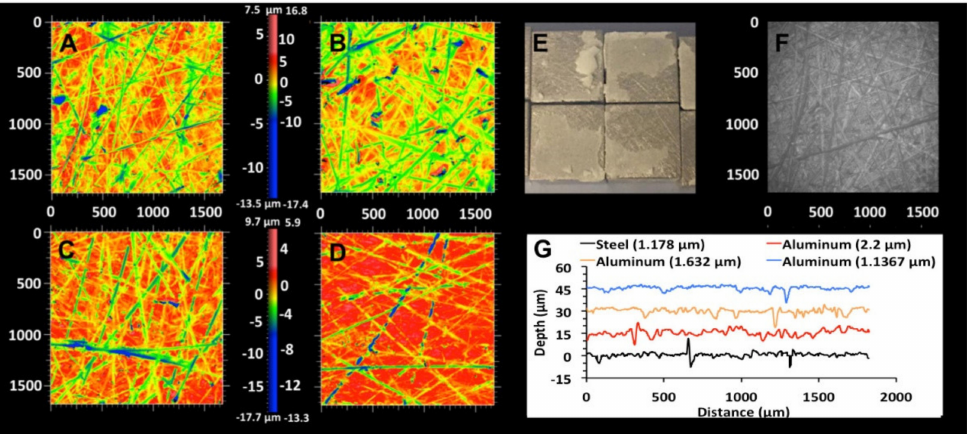
Figure 2. Surface properties of cubes used for shear testing. ( A–D ) 3D profiles of representative steel (A, S a = 1.23 µ m) and aluminum cube surfaces ( B – D , S a = 2.17, 1.72, 1.27 µ m, respectively). Each profile represents a surface 1.681 mm × 1.681 mm. ( E ) Steel cubes following shear testing with Phosphoserine-modified cement (PMC) remaining on the surface. ( F ) Optical image (profilometer) of steel surface, with the scale (0–1681 µ m) indicated on the X- and Y-axis. ( G ) One dimensional surface roughness plot of a representative surface from each group (S a values for each sample indicated). The scale bars in A–D and F are in µ m.